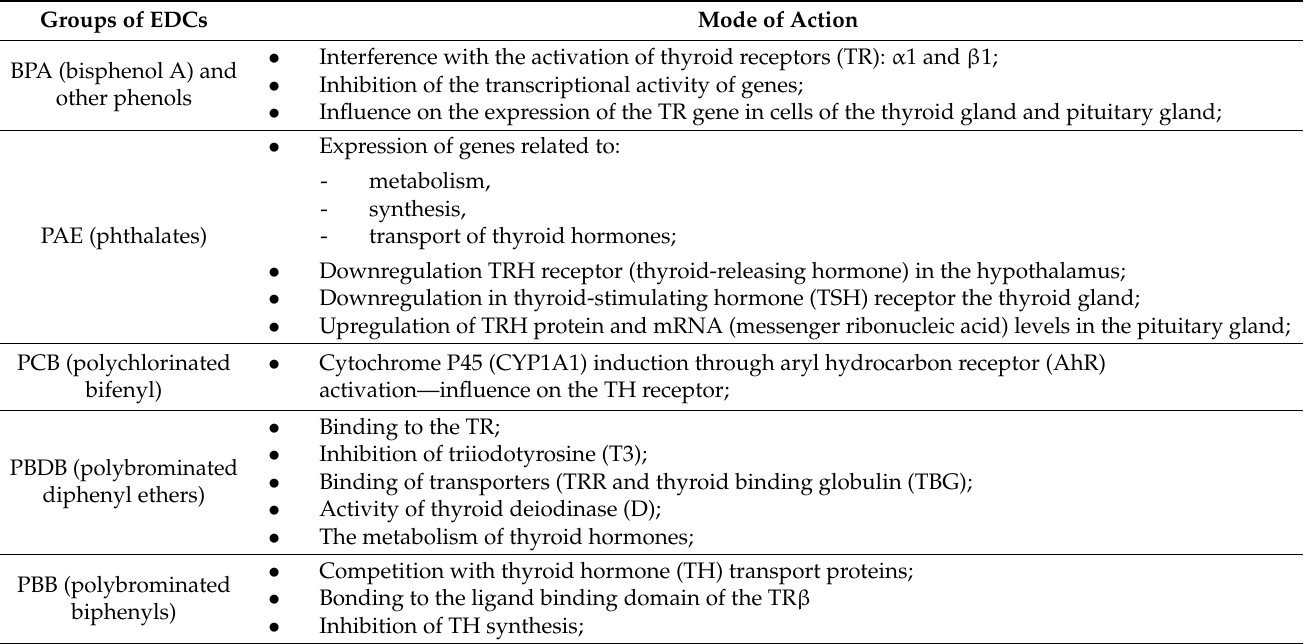
Table 1. Mode of action EDCs in in the hypothalamus–pituitary–thyroid axis